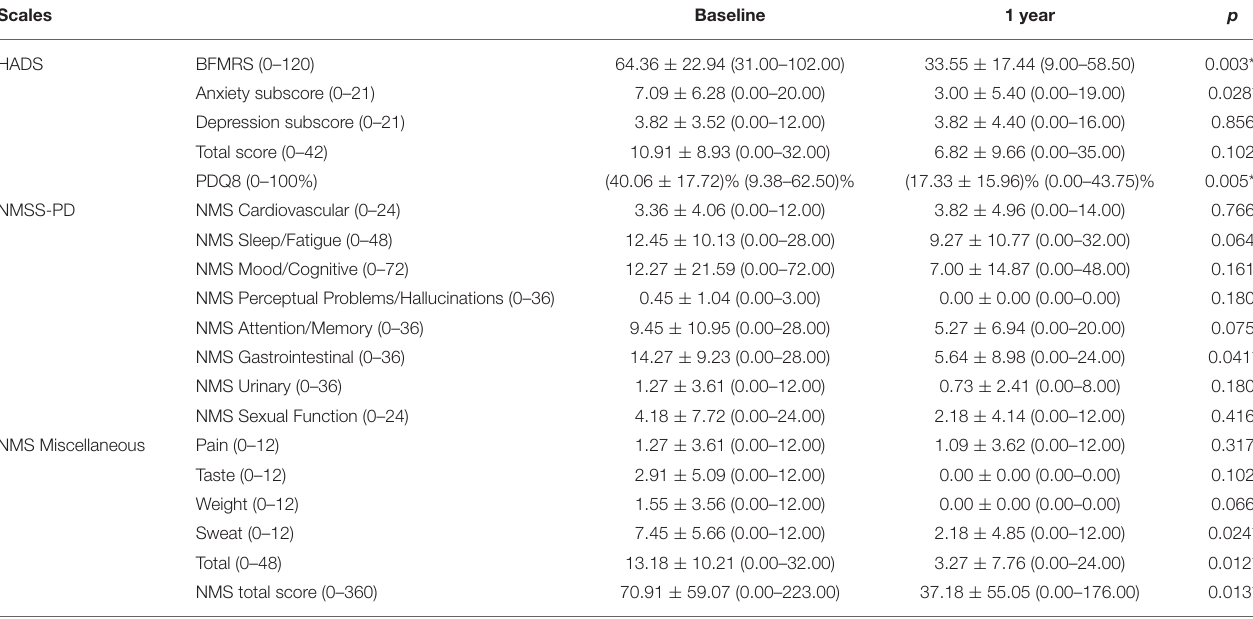
TABLE 1 | BFMRS, HADS, and NMS scale results. Scales